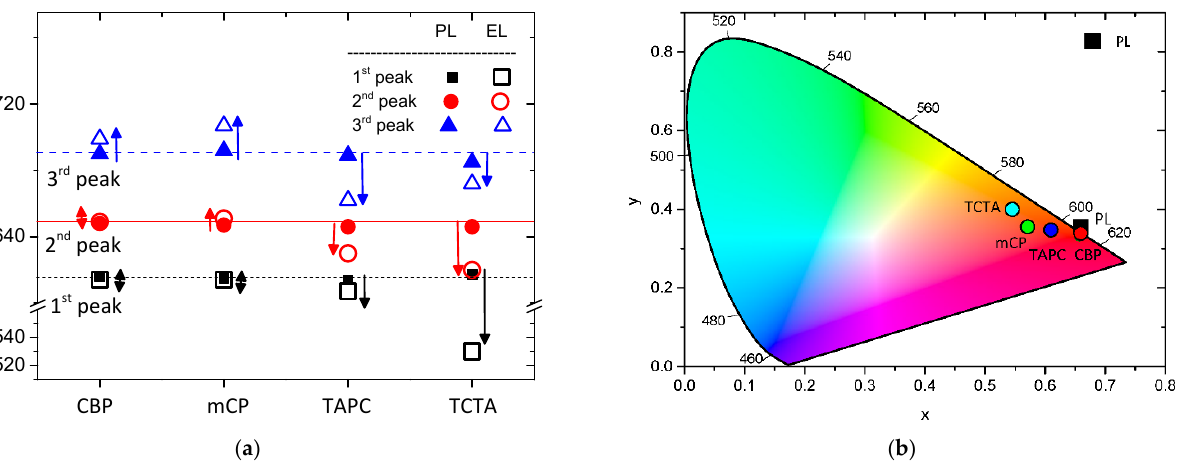
Figure 5. The normalized EL spectra of the PhOLED devices of the Ir-complex doped in: ( a ) CBP; ( b ) mCP; ( c ) TAPC; ( d ) TCTA as well as the respective PL spectra for comparison. Compared to the PL and EL emission, it is obvious that the tendency of the EL spectra was similar to the PL spectra. However, for all studied Hosts:Ir-complex, the EL emission profile is blue-shifted in comparison to the PL emission profile. According to the deconvolution analysis, there are fundamental differences in the shifts of the peaks either between the PL and EL of the different peaks of the same Host:Ir-complex film or between the same peak of the different films. These results are demonstrated in Figure 6a, in which the horizontal lines indicate the mean wavelength values of the three peaks, and the arrows denote the shift between the respective PL and EL peaks. Thus, we can distinguish that the smaller peak shifts are obtained for the Ir(dmpq) 2 (acac) doped CBP and the larger for the Ir(dmpq) 2 (acac) doped TCTA.